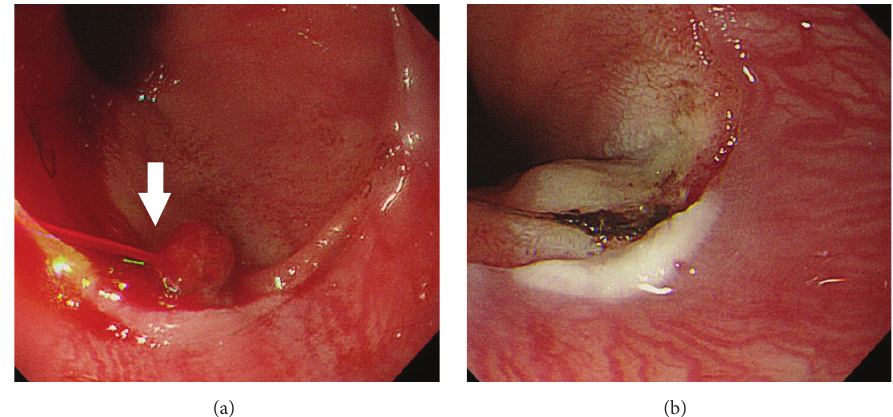
Figure 1: Endoscopic findings before and after hemostasis. (a) Active pulsatile bleeding from the esophagocardial junction (arrow). (b) Hemostasis by cauterization along with spraying of 10,000 IU of thrombin.